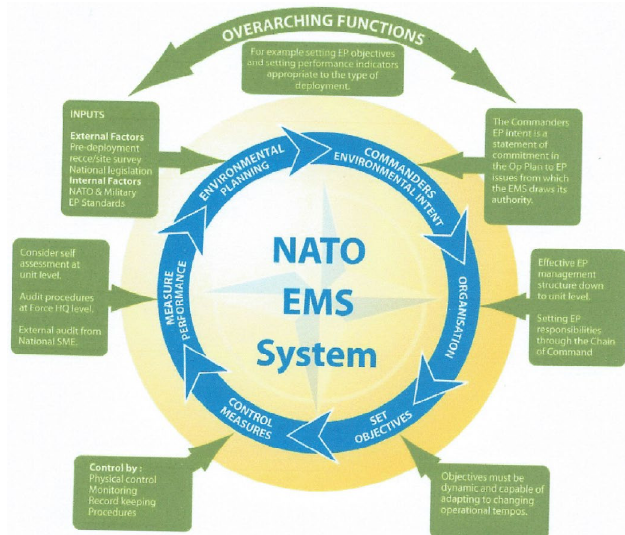
Fig. 2: NATO EMS structure planning (Source: NATO, 2008)